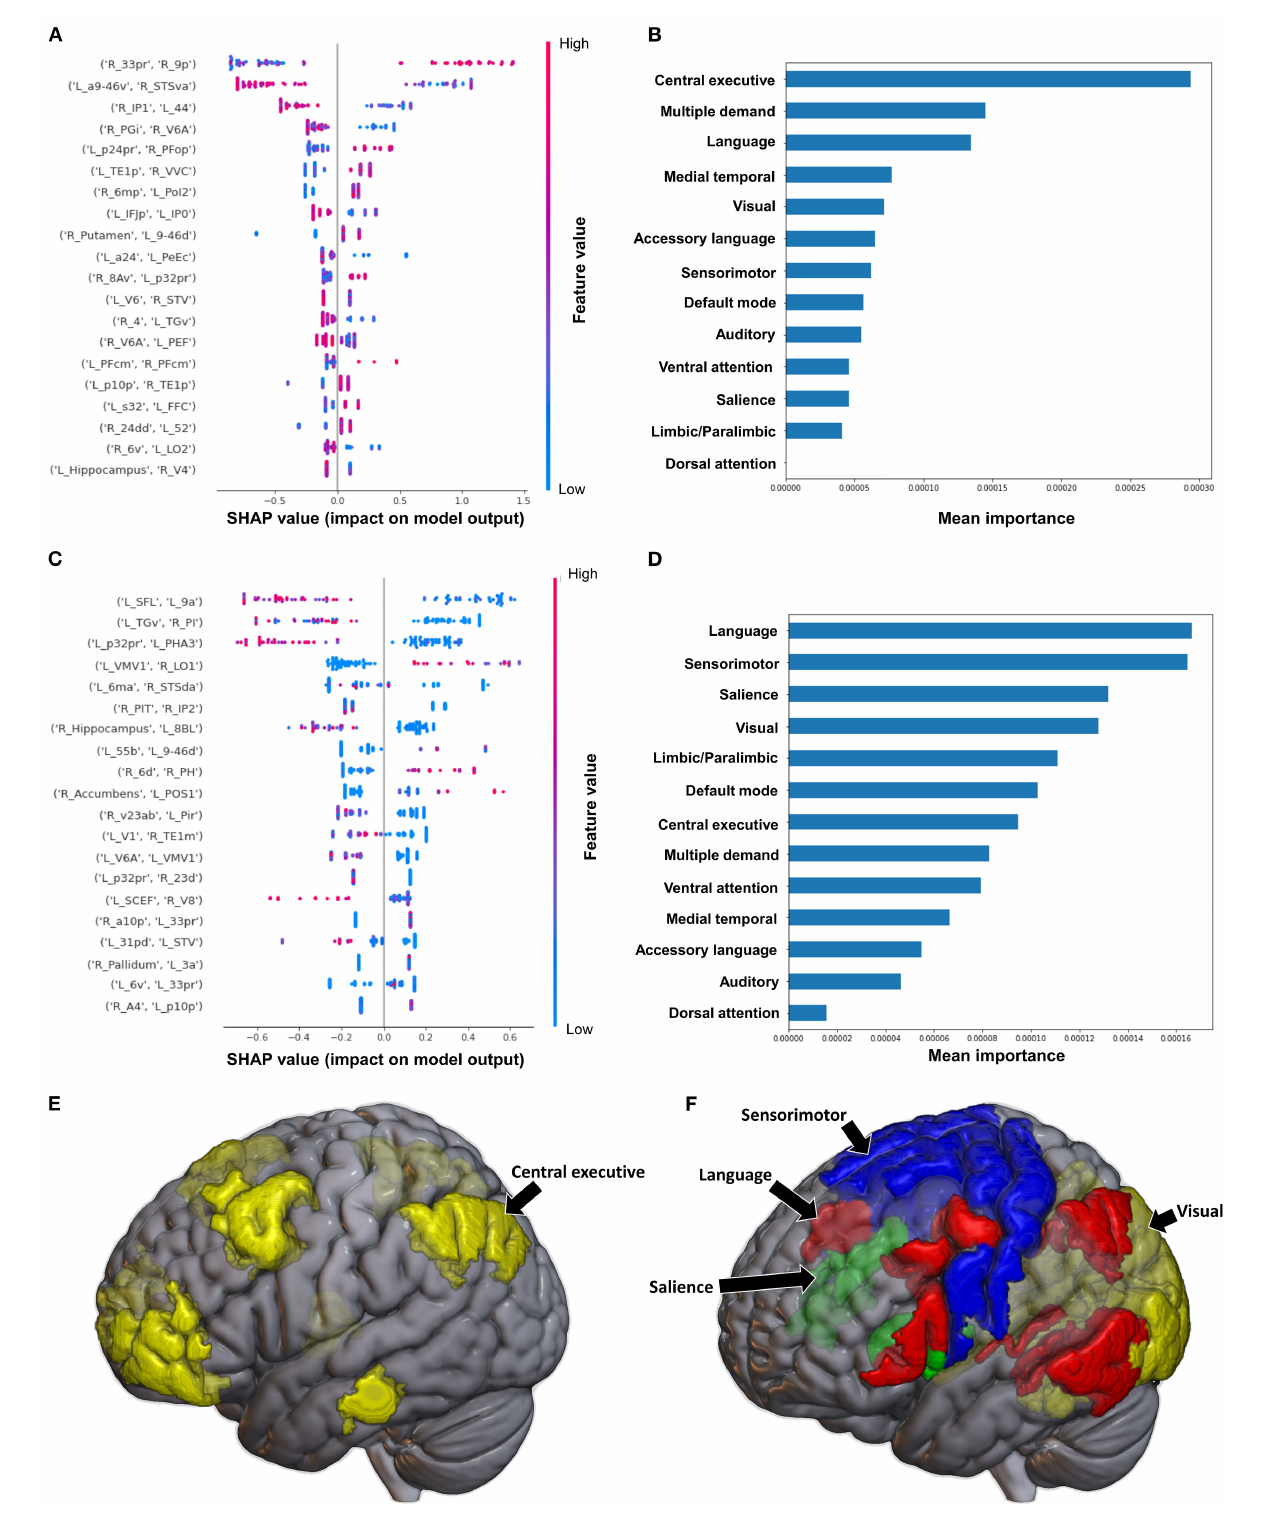
FIGURE8 Feature Importance Analysis of the models classifying the functional ambulation category based on functional connectivity at the (A) individual brain region level, and (B) the network level; and based on structural connectivity at the (C) the individual brain region level, and (D) the network level. The networks contributing most to the models’ classifications, based on (E) functional connectivity, and (F) structural connectivity, have also been visualized on brain